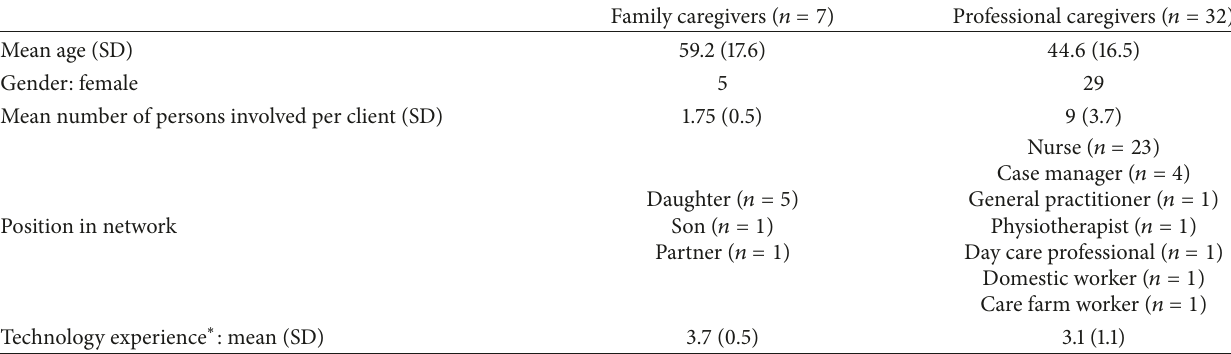
Table 2: Participant